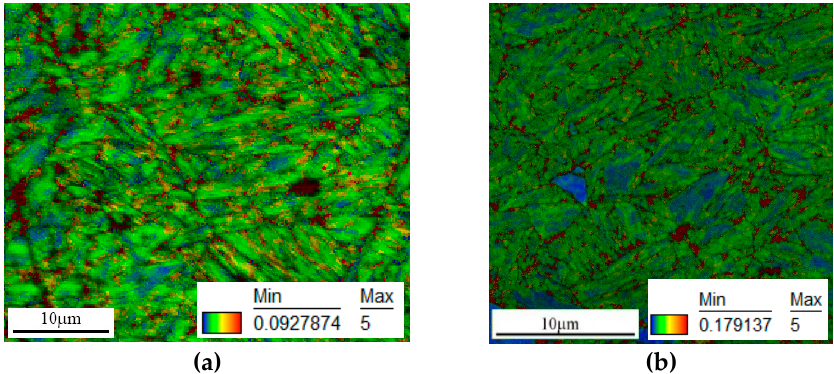
Figure 16. Kernel average misorientation (KAM) maps of different conditions in the initial phase zone; ( a ) initial sheet; ( b ) initial phase zone of hot stamping parts with tailored properties; ( c ) ε = 0.04; ( d ) ε = 0.607.